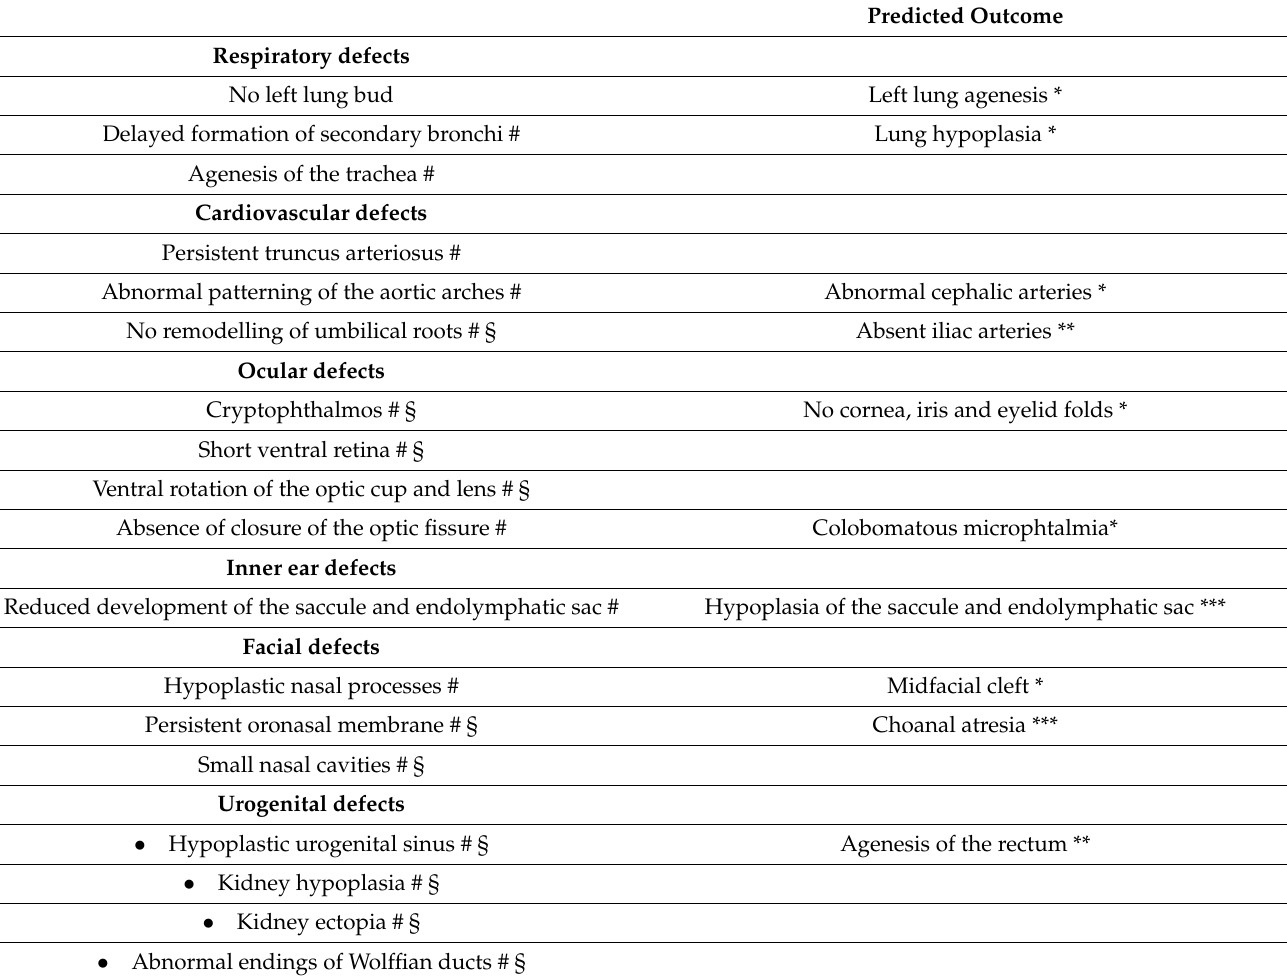
Table 1. Abnormalities displayed by Rarabg ∆ E9.5 mutants analysed by HREM at E10.5, E11.5, and/or E12.5 ( n = 3 at each developmental stage). # These abnormalities are completely penetrant. § These abnormalities are equal in frequency and severity to those present in Rarabg ∆ E10.5 mutants [4]. * From the phenotypes of Rara − / − ; Rarb − / − , Rara − / − ; Rarg − / − and Rarb − / − ; Rarg − / − KO mutants at late foetal stages [11–13]. ** From the phenotypes of Rarabg ∆ E10.5 mutants [4]. *** From the phenotype of Aldh1a3 − / − KO mutants at late foetal stages